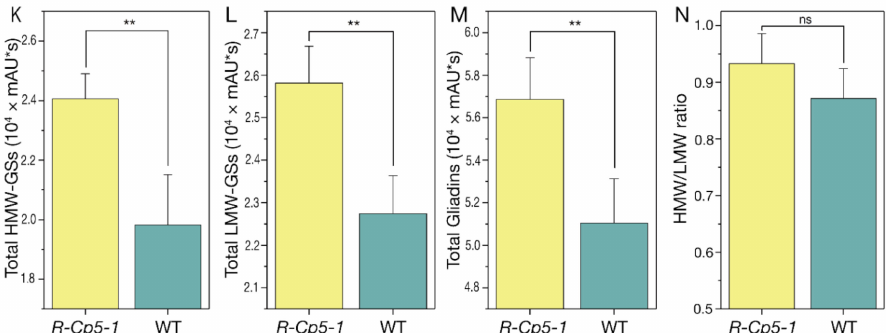
Figure 3. Q c5 results in relatively small seeds and increased processing quality. Length ( A ) and width ( B ) of 30 seeds from R-Cp5-1 (upper) and WT (lower). Scale bar, 1 cm. ( C ) Thousand kernel weight of R-Cp5-1 and WT. ( D – F ) Comparison of bread made from R-Cp5-1 and WT wheat. Scale bar, 1 cm. ( G – I ) Comparison of the grain protein content ( G ), wet gluten content ( H ), and Zeleny sedimentation value ( I ) between R-Cp5-1 and WT. ( J – N ) The Glu/Gli ratio ( J ), total HMW-GS ( K ), total LMW-GS ( L ), total gliadins ( M ), and HMW/LMW ratio ( N ) were greater for R-Cp5-1 than for WT. Data are presented as the mean ± standard deviation ( n = 4; *, p ≤ 0.05; **, p ≤